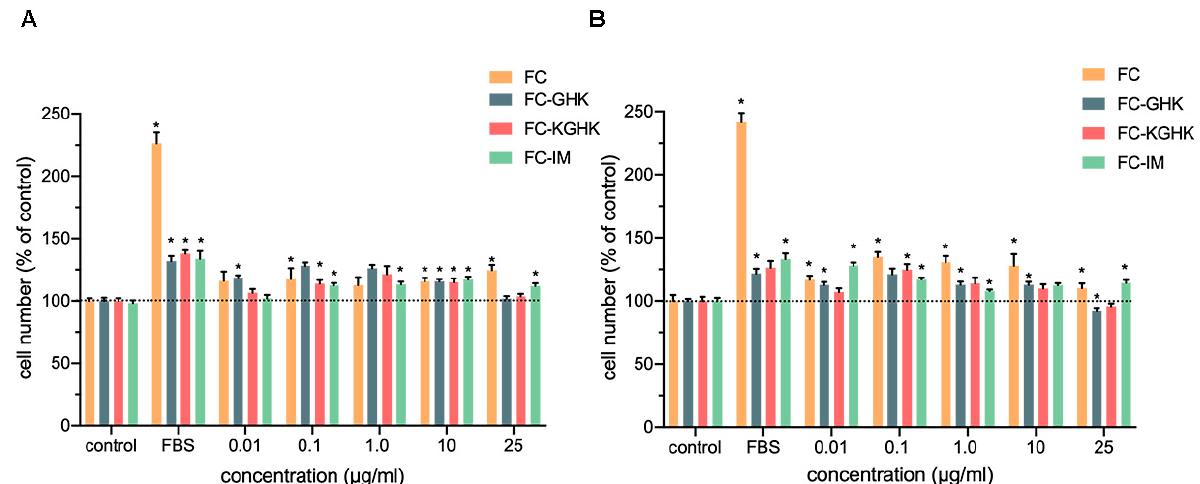
Figure 10. Peptide effect on proliferation of HaCaT keratinocytes after ( A ) 48 h and ( B ) 72 h incubation. The graphs show results from four independent experiments (four replicates in each, n = 16). Results are presented as mean with SEM. *- statistically significant differences compared to control, Mann-Whitney U test, p < 0.05. FBS-positive control cells grown in medium containing 10% FBS.